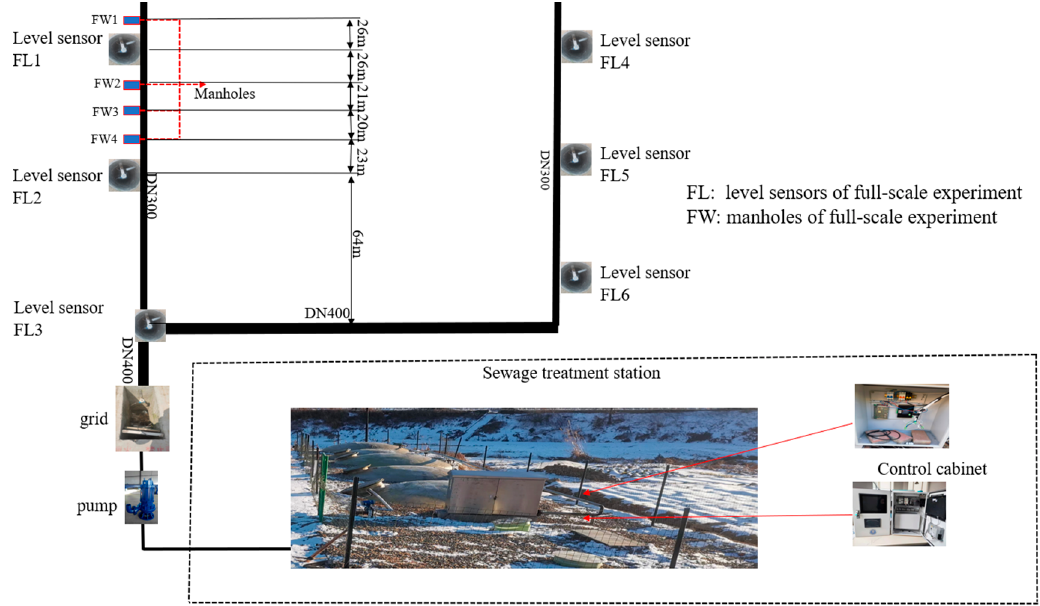
Figure 3. Full-scale experimental system diagram for sewer blockage identification.